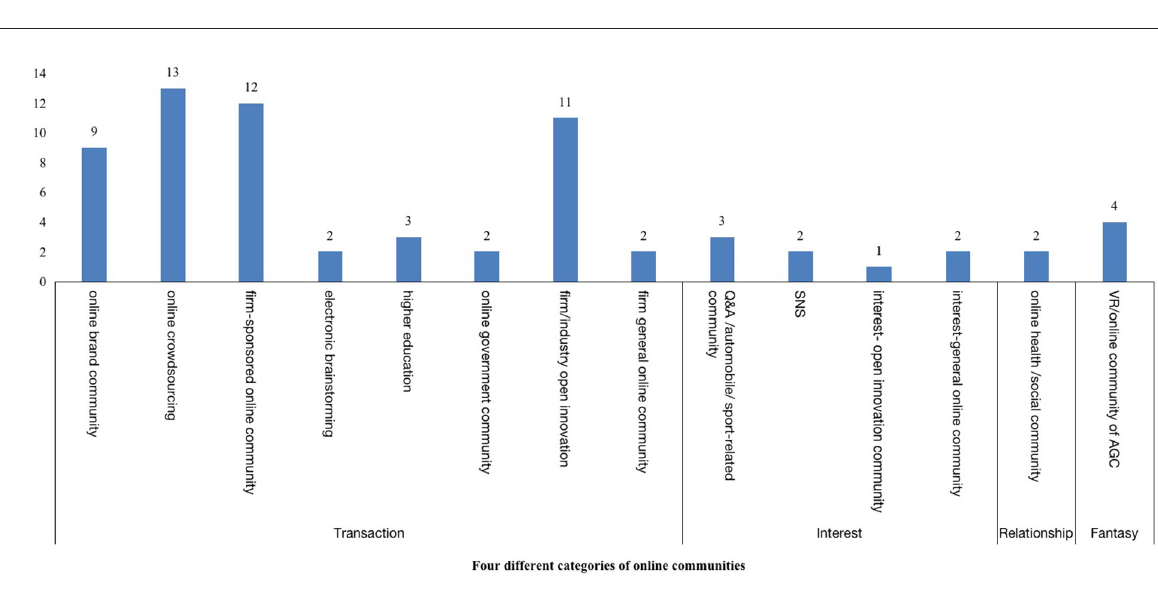
FIGURE4 Selected articles by types of virtual